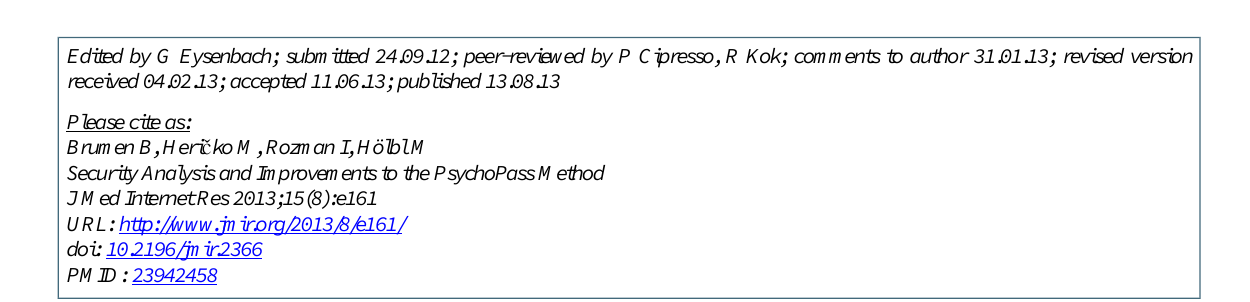
QWERTZ: widely used keyboard layout in Central Europe. The name comes from the first 6 letters at the top left of the keyboard.